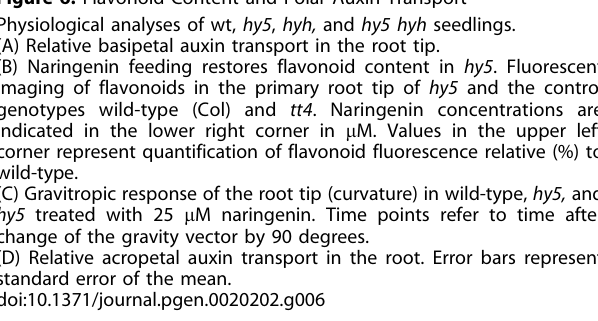
Figure 6. Flavonoid Content and Polar Auxin Transport Physiological analyses of wt, hy5 , hyh, and hy5 hyh seedlings. (A) Relative basipetal auxin transport in the root tip. (B) Naringenin feeding restores flavonoid content in hy5 . Fluorescent imaging of flavonoids in the primary root tip of hy5 and the control genotypes wild-type (Col) and tt4 . Naringenin concentrations are indicated in the lower right corner in l M. Values in the upper left corner represent quantification of flavonoid fluorescence relative (%) to wild-type. (C) Gravitropic response of the root tip (curvature) in wild-type, hy5, and hy5 treated with 25 l M naringenin. Time points refer to time after change of the gravity vector by 90 degrees. (D) Relative acropetal auxin transport in the root. Error bars represent standard error of the mean.